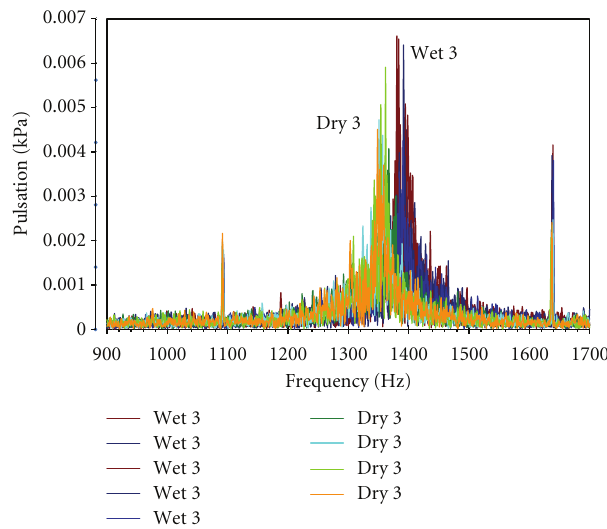
Figure 13: Comparison of raw frequency spectra wet versus dry focused on 1400 Hz mode.